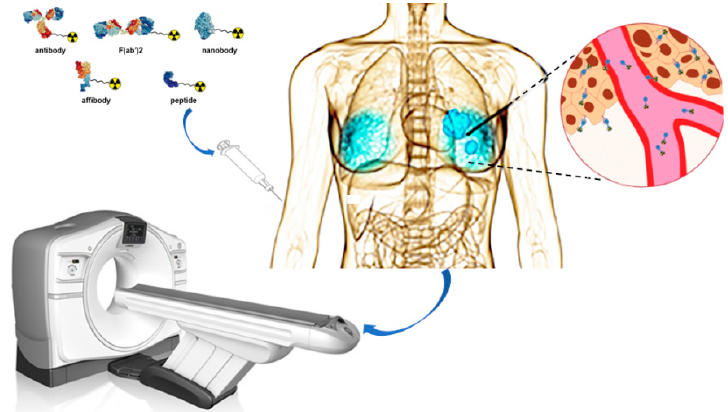
Figure 1. Schematic overview of nuclear imaging for Her2 positive BC. Ligands such as antibody, F(ab’)2 fragments, nanobody, affibody, and peptide can be coupled to a chelator. The chelator enables labeling with different radionuclides that can be applied for imaging purposes.